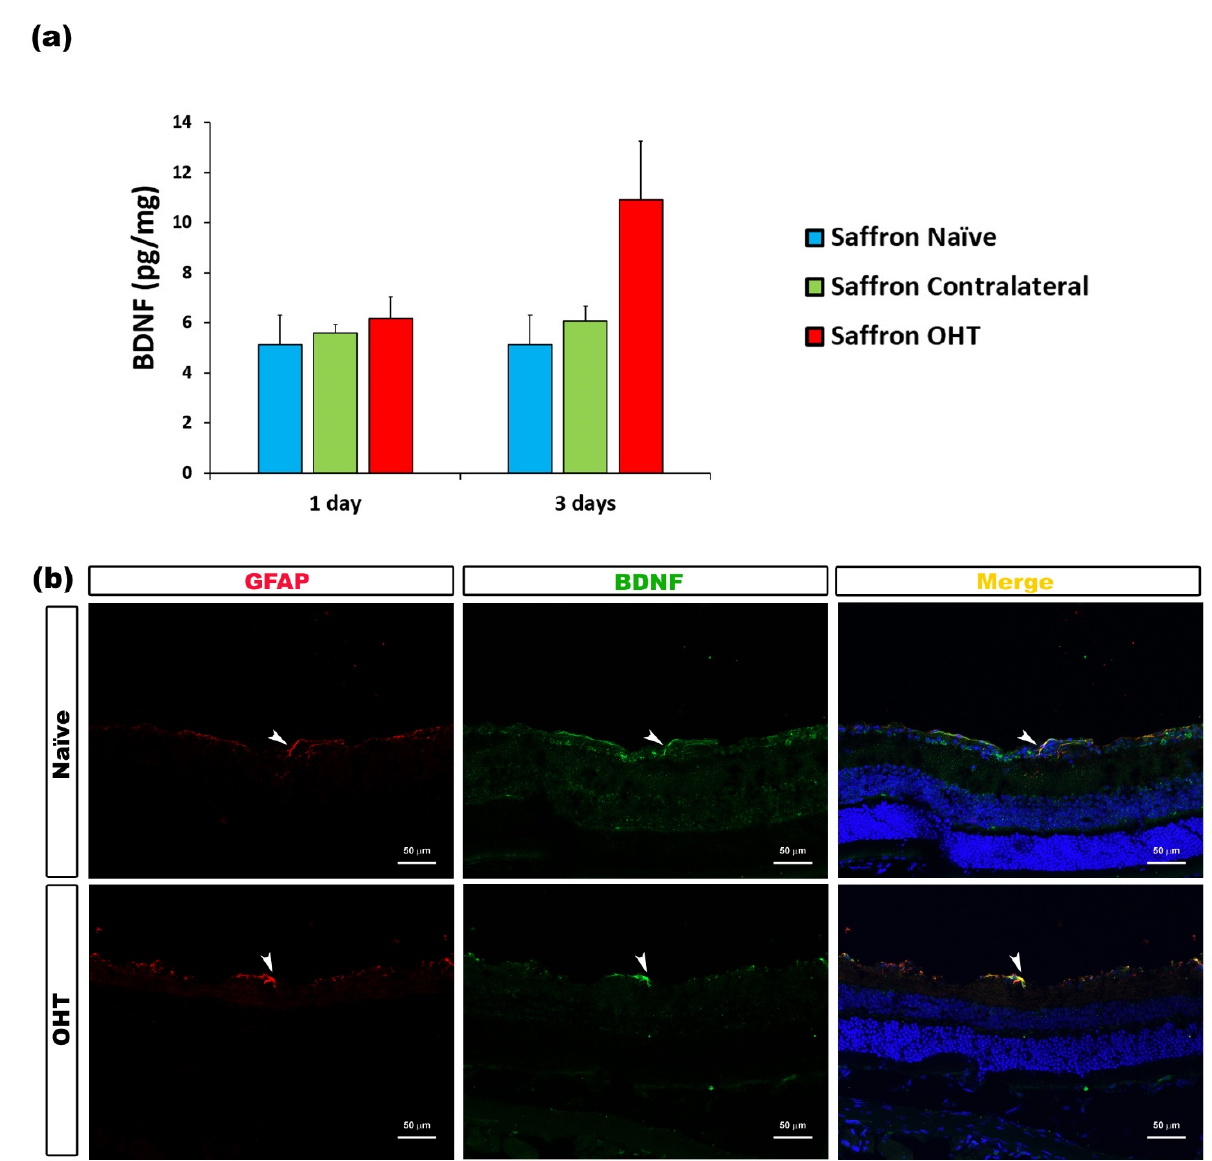
Figure 9. BDNF levels at 1 and 3 days after laser-induced ocular hypertension (OHT). ( a ) The BDNF values obtained in the multiplex assay. The histogram shows the mean levels (± SD) of BDNF (pg/mg) at days 1 and 3 after laser OHT induction in saffron ocular hypertension eyes (saffron OHT), saffron-contralateral eyes (saffron-contralateral), and naïve eyes. ( b ) Immunohistochemical study of BDNF expression in saffron OHT eyes three days after unilateral laser-induced OHT. Retinal sections were immunolabeled with antibodies to BDNF (green) and GFAP (red). Merge is denoted by the colour yellow. The arrowhead shows the co-expression of GFAP and BDNF in saffron OHT and saffron-naïve eyes. Abbreviations: OHT (ocular hypertension); BDNF (brain-derived neurotrophic factor); GFAP (glial fibrillary acidic protein).